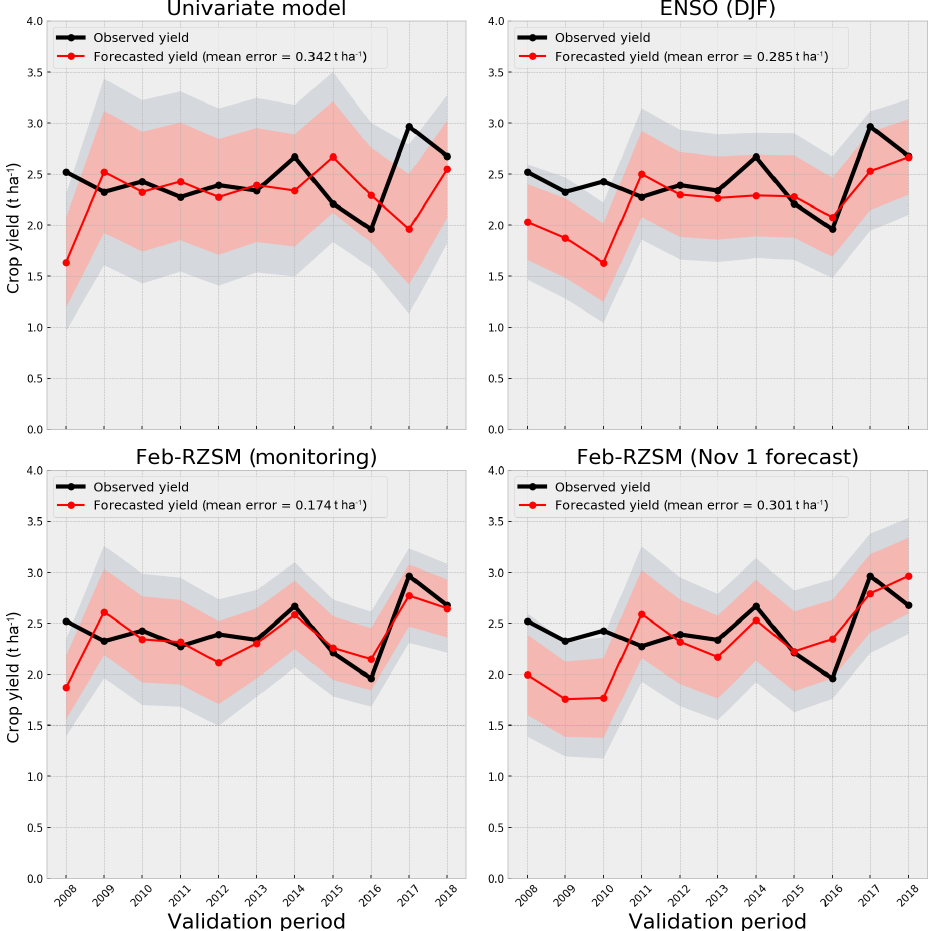
Figure 8. Comparison of the performance of a univariate model alone, ENSO (DJF), Feb-RZSM (monitoring product), and Feb-RZSM (forecasting product) as a predictor in forecasting crop yield of southern Africa. Pink (gray) shading indicates 80% (95%) confidence